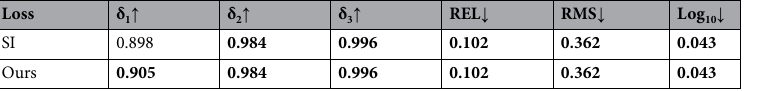
Table 9. Quantitative comparison of different loss functions for pixel-level depth of final prediction. The better results are shown in bold.